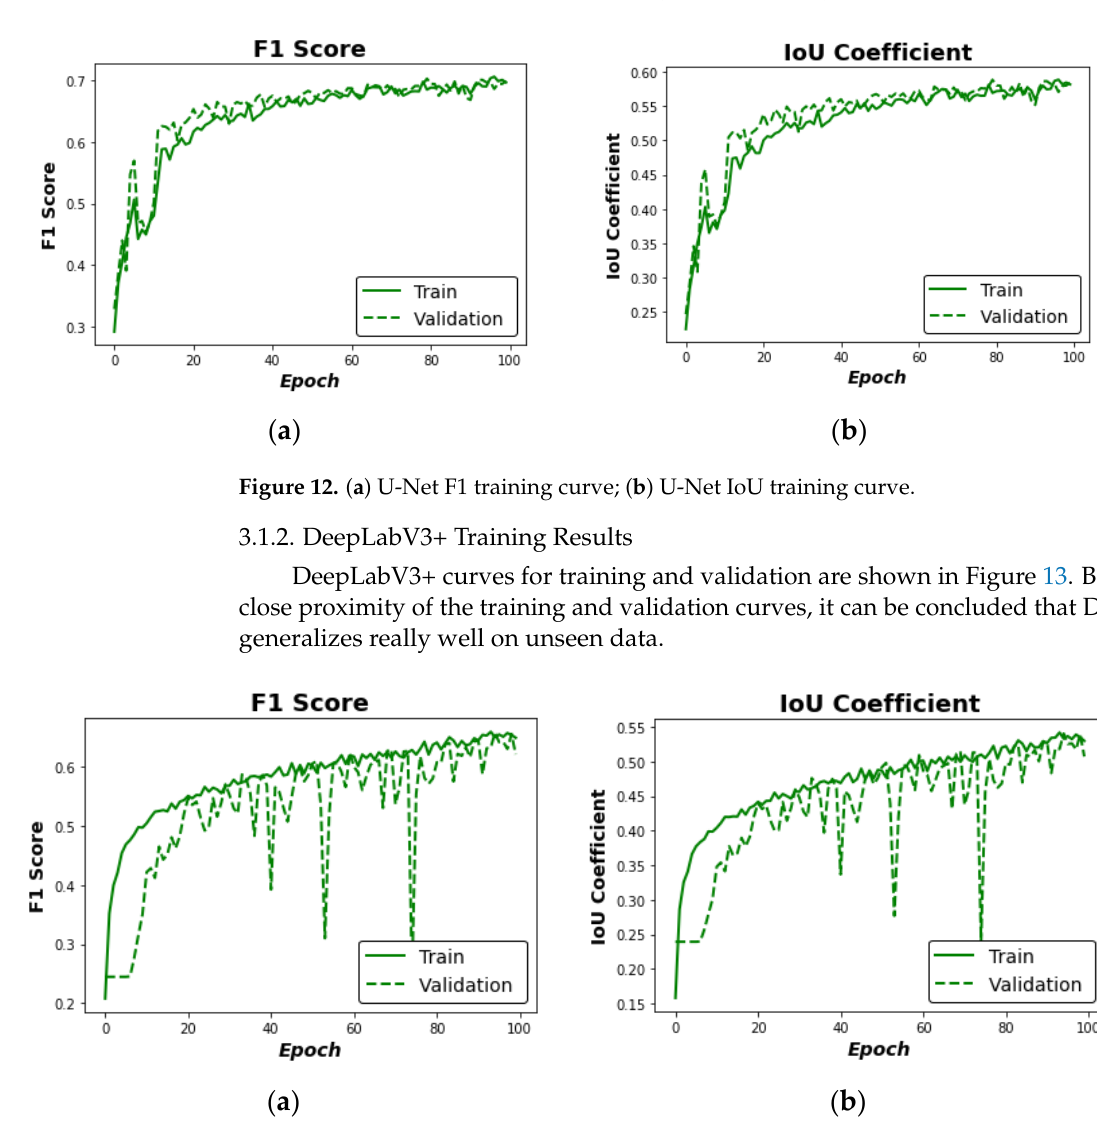
Figure 13. ( a ) DeepLabV3+ F1 training curve; ( b ) DeepLabV3+ IoU training curve.